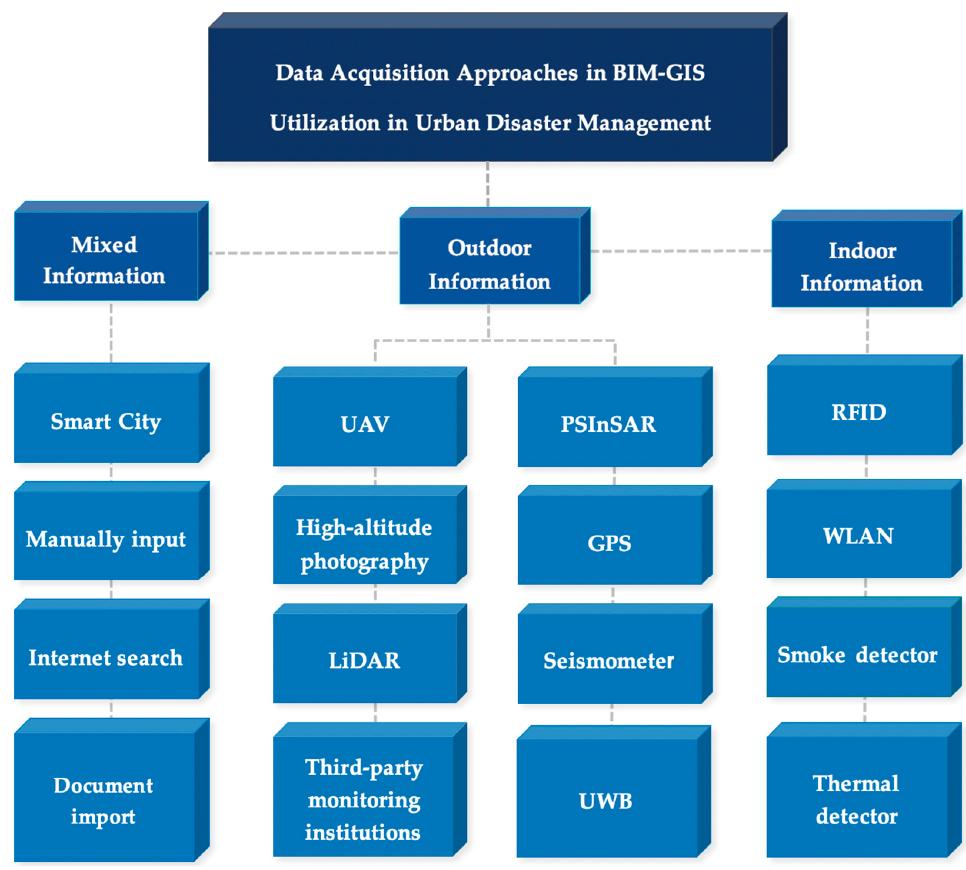
Figure 7. Data Acquisition Approaches in BIM–GIS Utilization in Urban Disaster